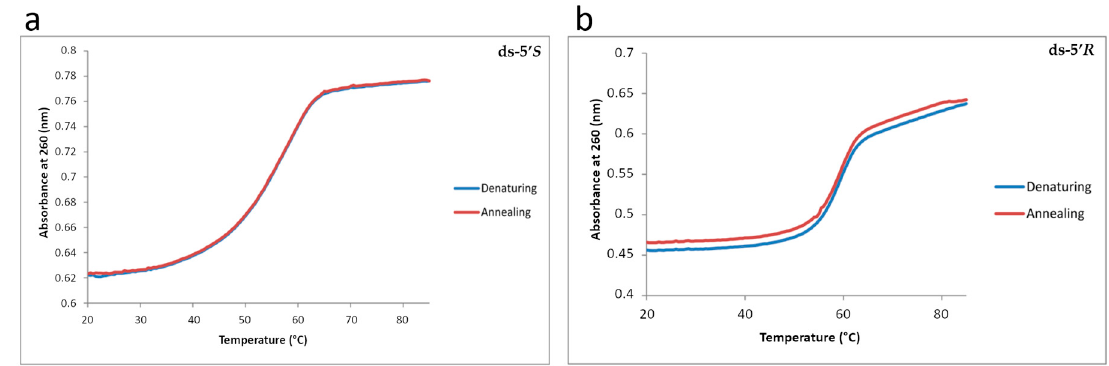
Figure 2. Ultraviolet ( UV)melting curves of 23-mer duplexes containing ( a ) 5’ S -cdA lesion and ( b ) 5’ R -cdA lesion. UV melting curve of unmodified double stranded is shown in Figure S3.